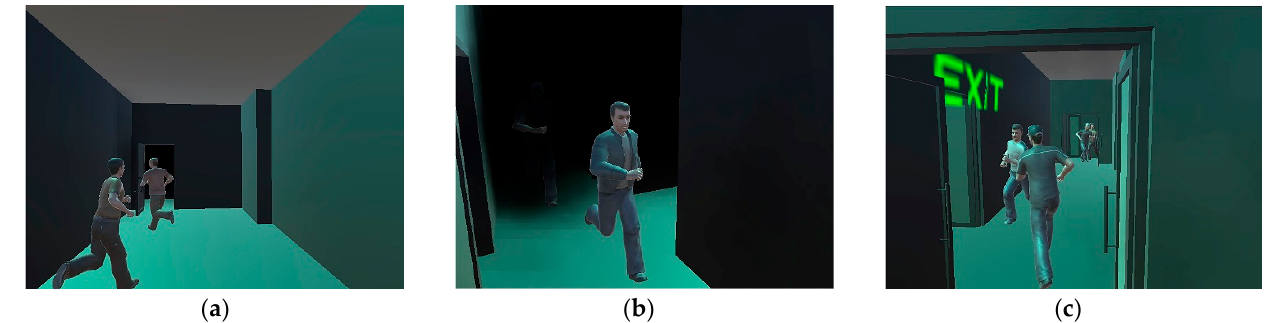
Figure 7. Evacuation drill process. ( a ) Initial position; ( b ) In evacuation; ( c ) Evacuation exit.